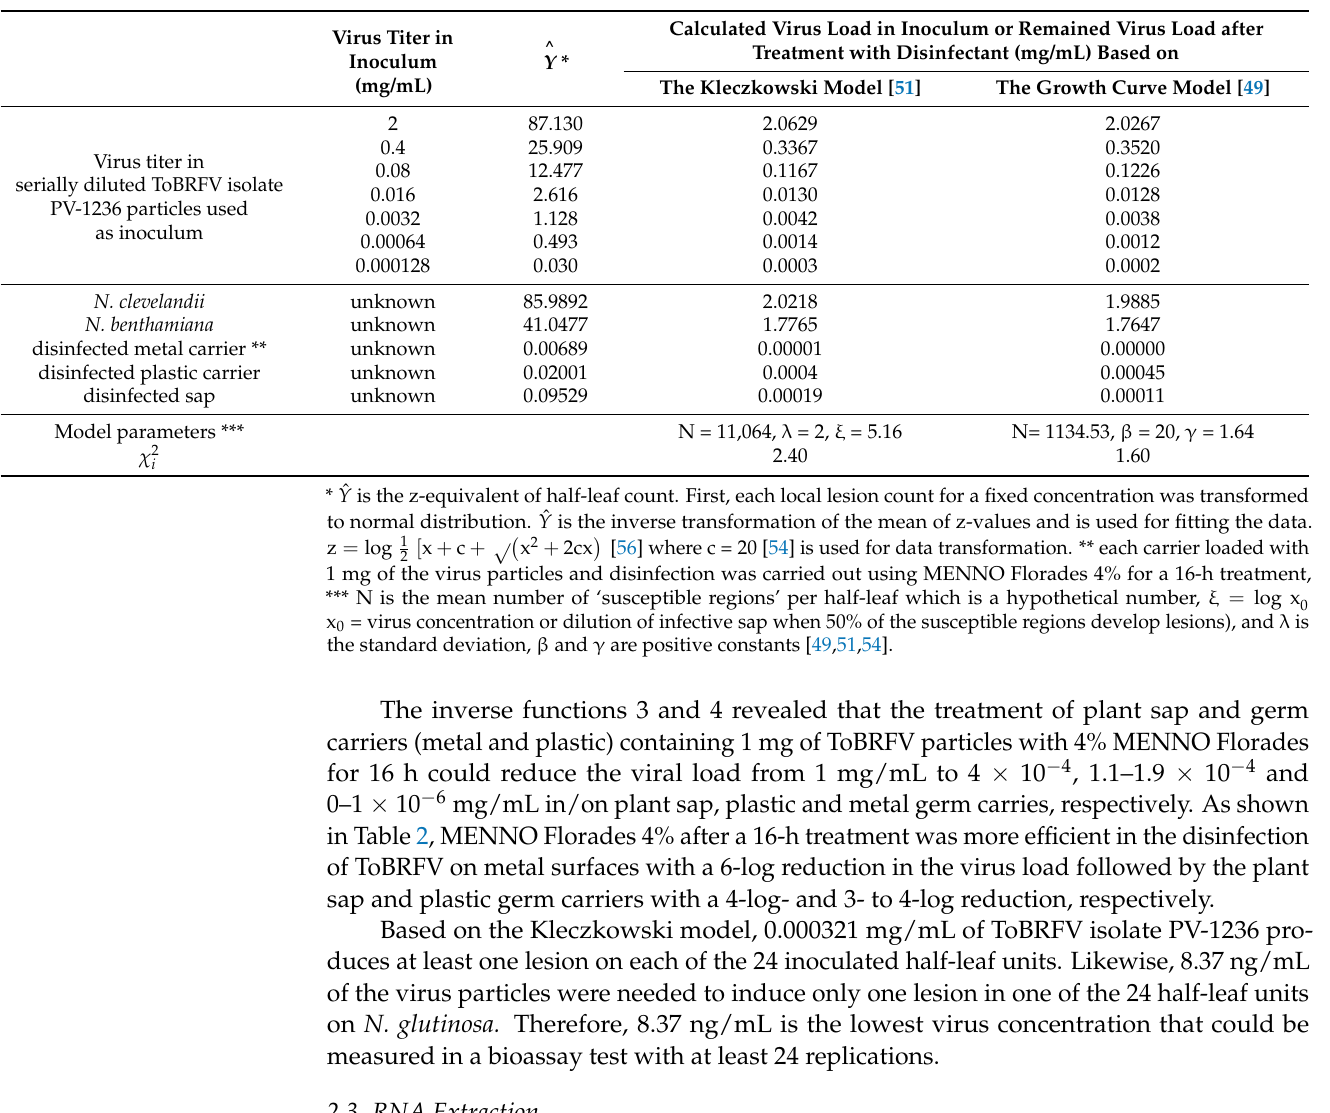
Table 2. Mean number of transformed data and model parameters for correlation of the necrotic local lesions on N. glutinosa with serially diluted ToBRFV suspensions and computed concentration of ToBRFV in different samples based on the obtained models. Data transformation was performed according to Section